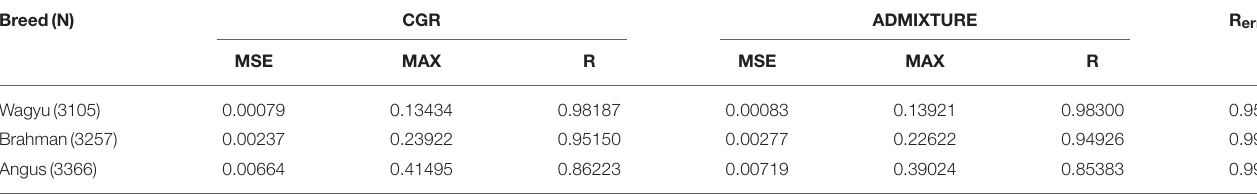
TABLE 5 | Statistic of the genome proportion estimation errors from type-2 robustness trials for the cattle data set when CGR or ADMIXTURE was used.